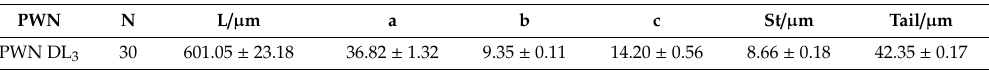
Table 1. Morphological measurements of third-stage dispersal juveniles of pinewood nematode isolated from P. tabuliformis in Fushun.